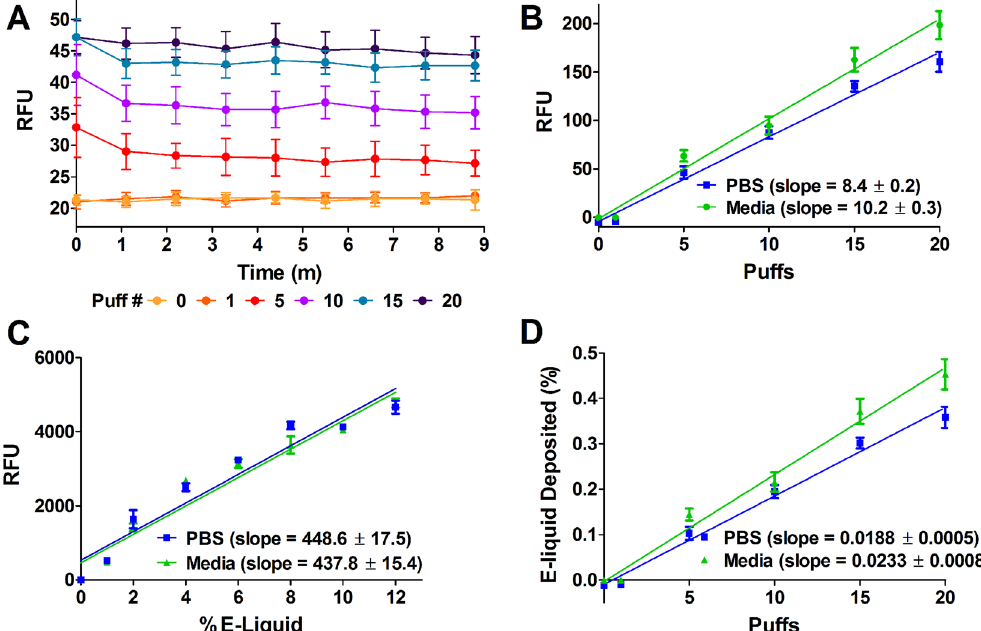
Figure 5. E-liquid deposition quantification by autofluorescence. Grape Soda e-liquid was vaped into PBS or media using 70 mL puffs generated at 40 W. ( A ) Fluorescence intensity did not change significantly with deposition after 9 minutes (n = 6). ( B ) Fluorescence intensity was proportional to number of puffs. Slopes of regression line were 8.4 ± 0.2 (R 2 = 0.94) and 10.2 ± 0.3 (R 2 = 0.92) for PBS and media, respectively (n = 6). ( C ) Fluorescence intensity was proportional to e-liquid concentration. Slopes of regression line were 448.6 ± 17.5 (R 2 = 0.92) and 437.8 ± 15.4 (R 2 = 0.94) for PBS and media, respectively (n = 6). ( D ) E-liquid deposition (% v/v) was directly proportional to the number of puffs. Slopes of regression line (y-intercept constrained to 0) were 0.0188 ± 0.0005 (R 2 = 0.94) and 0.0233 ± 0.0008 (R 2 = 0.92) for PBS and media, respectively (n =